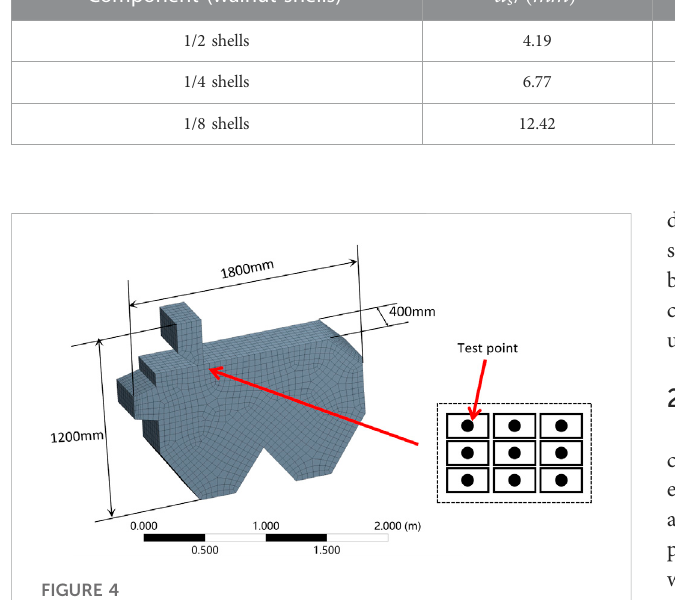
TABLE 1 Windward area equivalent ball diameter information table. Component (walnut shells)